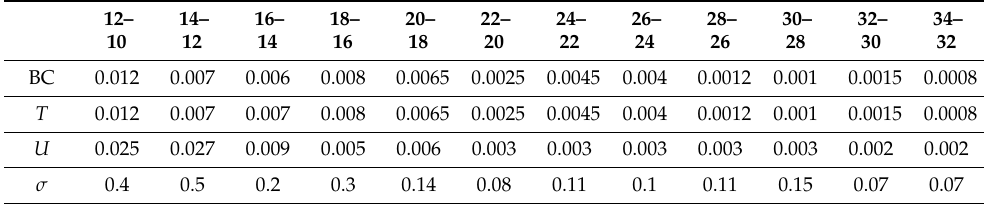
Table 2. The maximum norm for differences (upper row) for boundary condition BC and for temperature, displacement, and stress in the space-time domain.